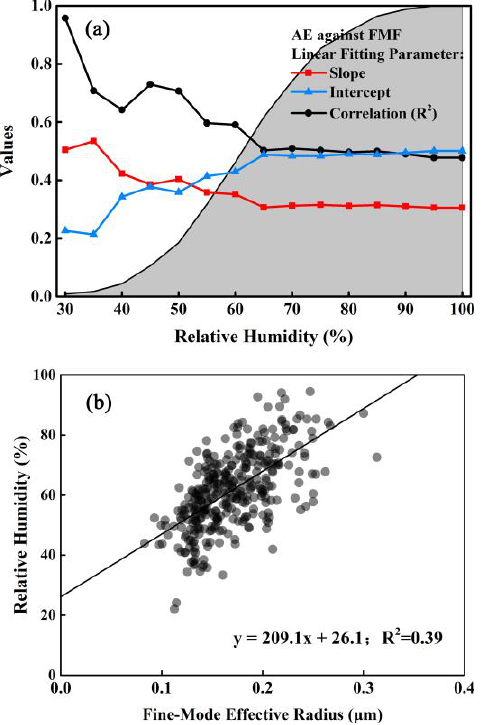
Figure 4. Influence of RH on aerosols. (a) Relationship of FMF (440 nm) and AE (440-870 nm) changes with the RH. Slope, intercept and R 2 in the plots are parameters of the linear fitting, representing trends and correlations at different RH conditions. Shadow is cumulative probability distribution of RH and it also represents proportion of sample in the total. (b) Dependence of fine-mode effective radius on RH. The black line is linear fitting line.